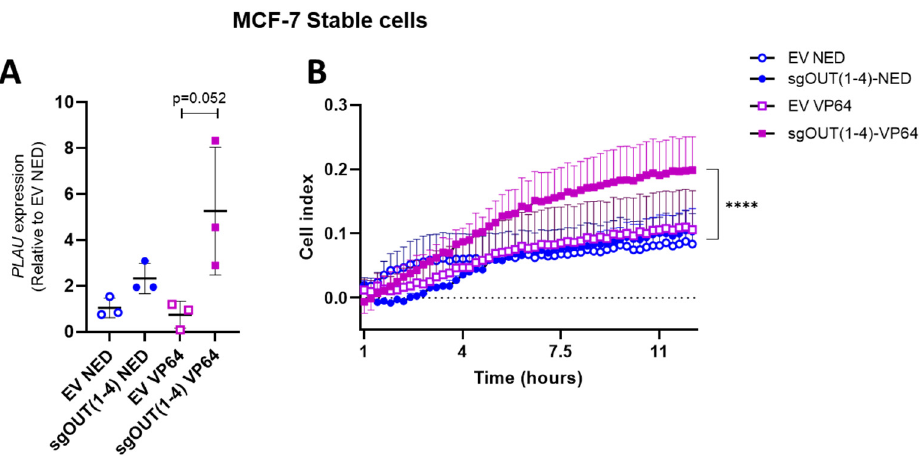
Figure 4. PLAU upregulation and its functional effect in stable MCF-7 cells . ( A ) qRT-PCR results of PLAU mRNA expression in stable MCF-7 cells using the sgOUT(1–4) or EV as negative control ( B ) Migration assay results of the cells transfected in ( A ). Data are represented as means of 3 independent experiments, relative to GAPDH and normalized to MCF-7-NED + EV; **** p < 0.001.